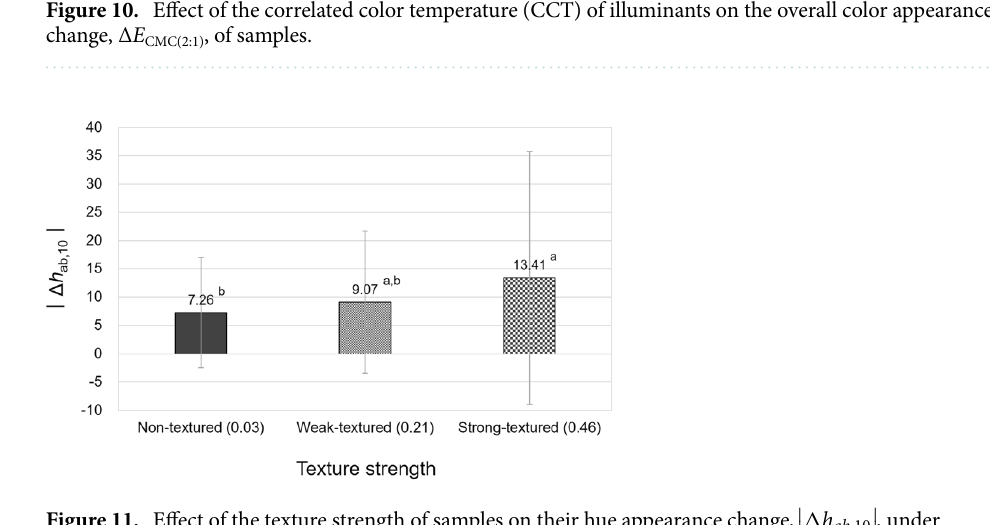
Figure 11. Effect of the texture strength of samples on their hue appearance change, illuminants. (Δ h ab,10 = h A under the illuminant—spectrophotometrically measured h ab,10